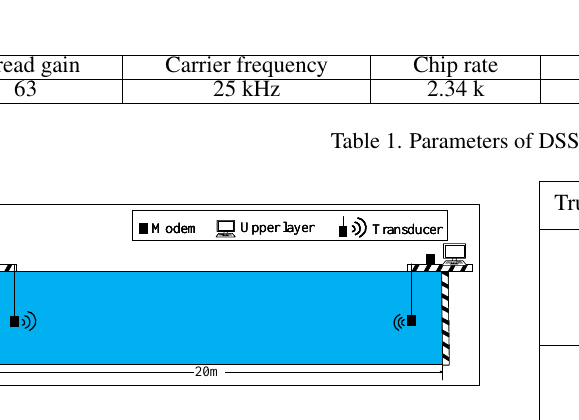
Figure 4. Experiment configuration.